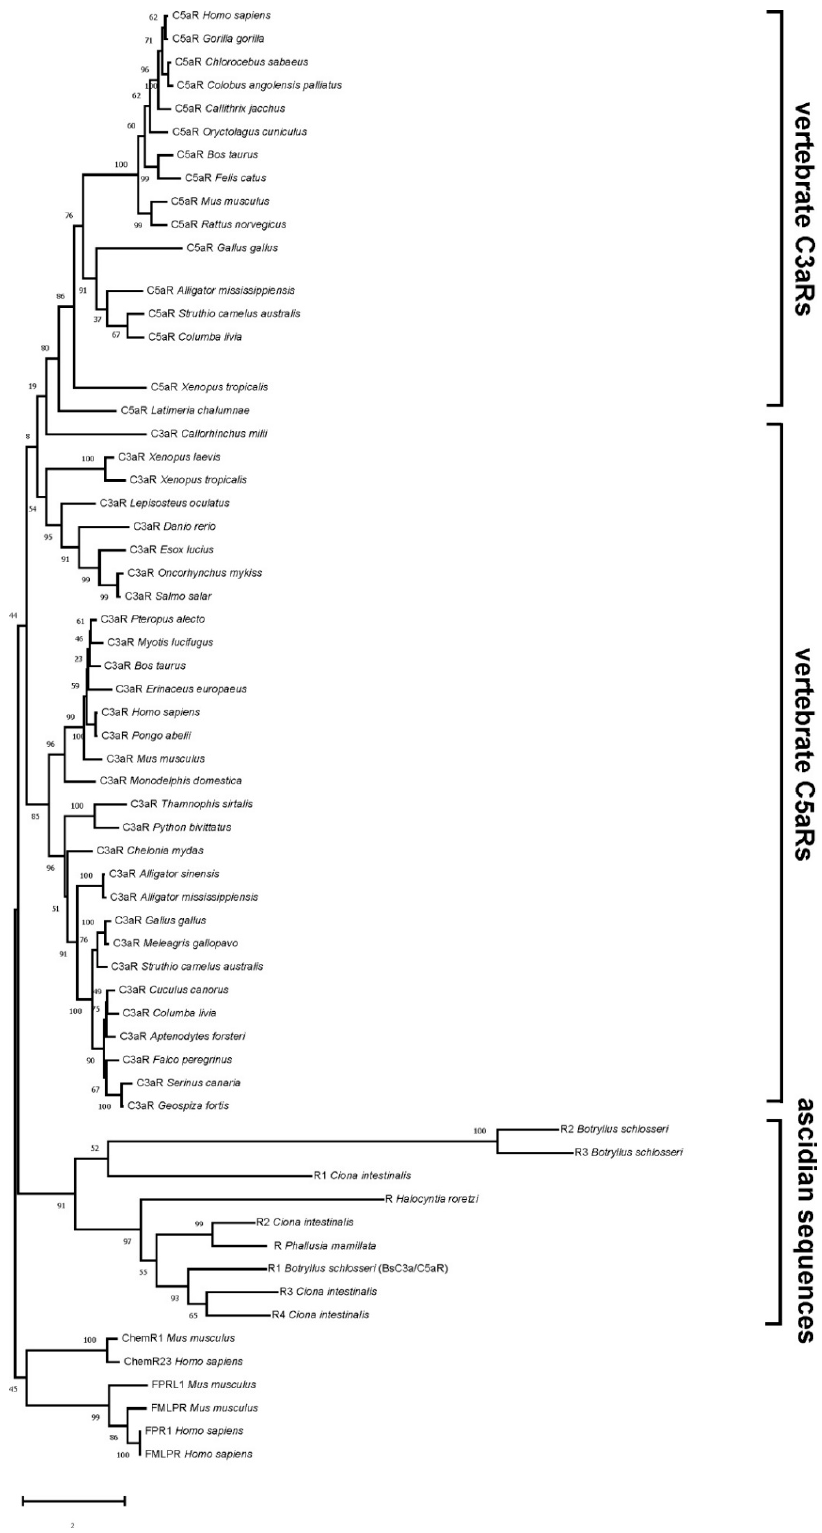
Figure 2. Evolutionary relationships among deuterostome anaphylatoxin receptors obtained with the maximum likelihood (ML) method. Similar topologies were obtained with neighbor joining (NJ) and unweighted pair group method with arithmetic mean (UPGMA). Bootstrap confidence values are indicated at the left of each branch. Sequence accession numbers are reported in Table S2.